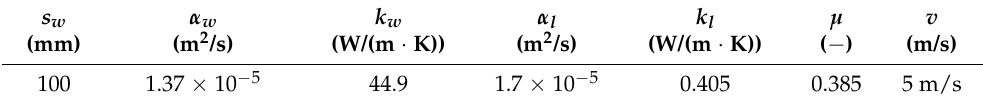
Table 2. Physical parameters for sliding temperature solutions of the friction lining-wire rope contact.